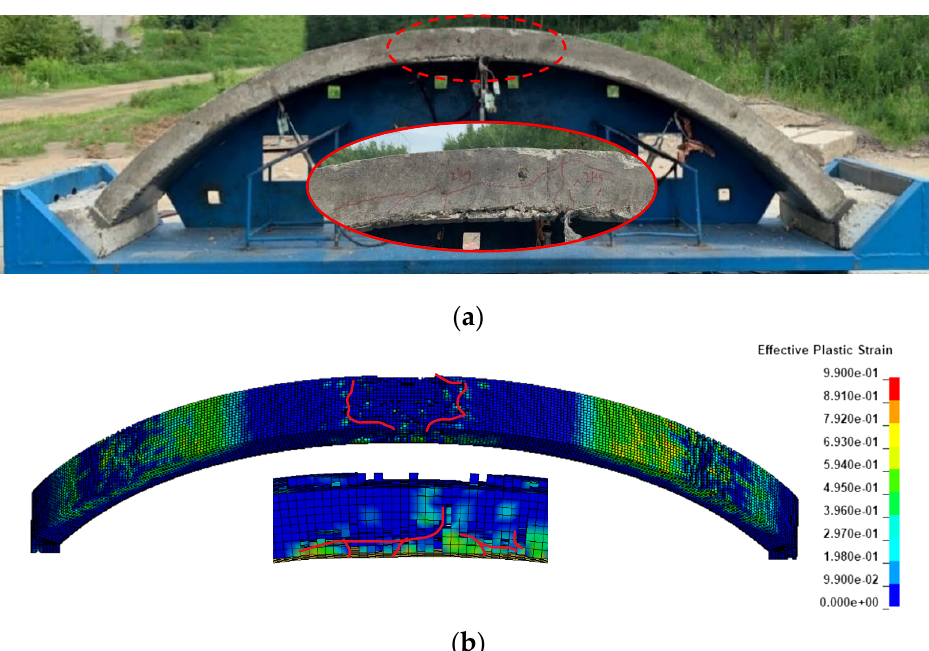
Figure 6. Damage to A2 ( a ) Experimental ( b ) Simulation.